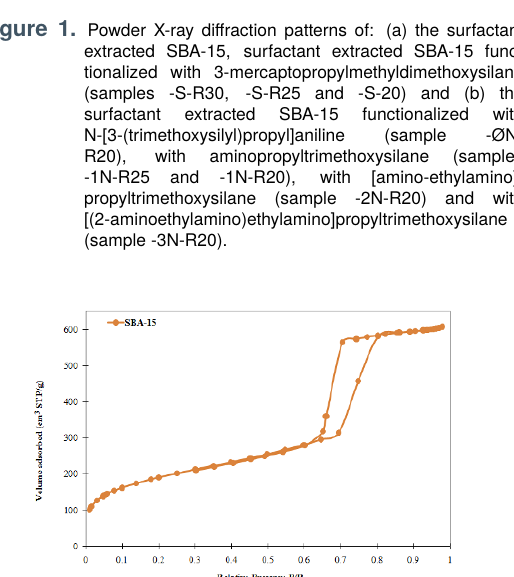
2 weight ratio for -ØN-R20, -3N-R20 and -1N-R20